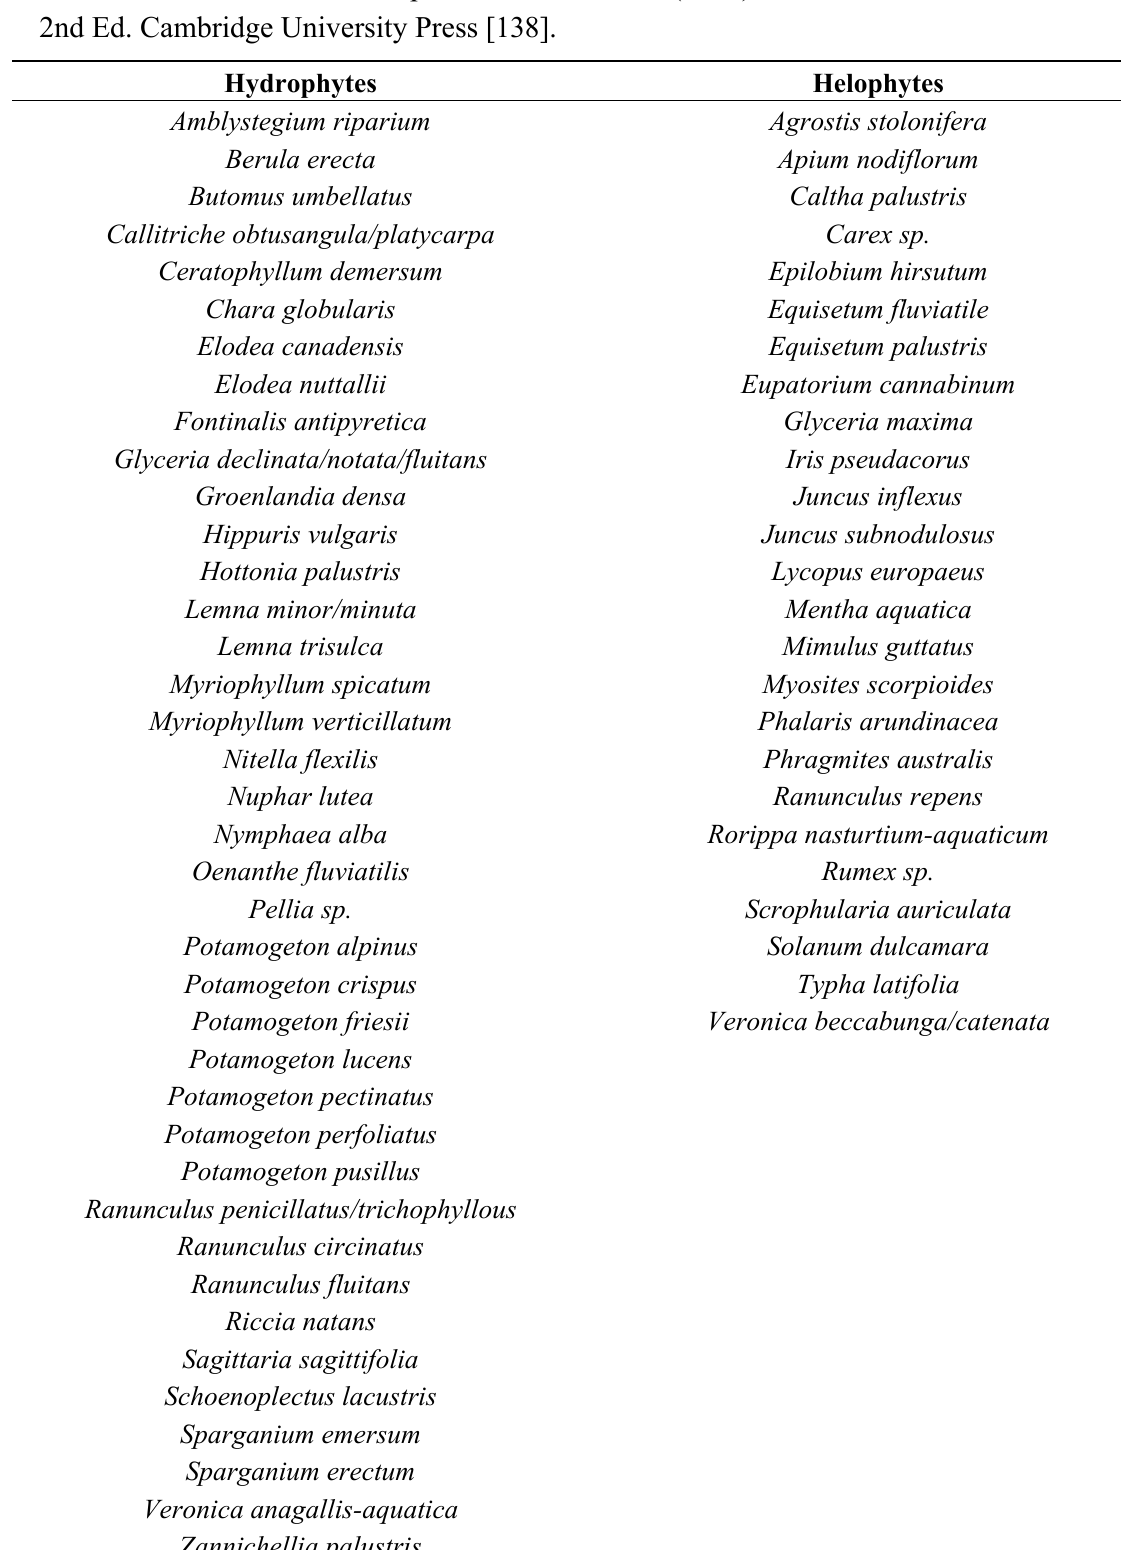
Table A3. List of hydrophyte and helophytes species from Norfolk rivers (England). The nomenclature of the vascular plants follows Stace (1997) New Flora of the British Isles 2nd Ed. Cambridge University Press